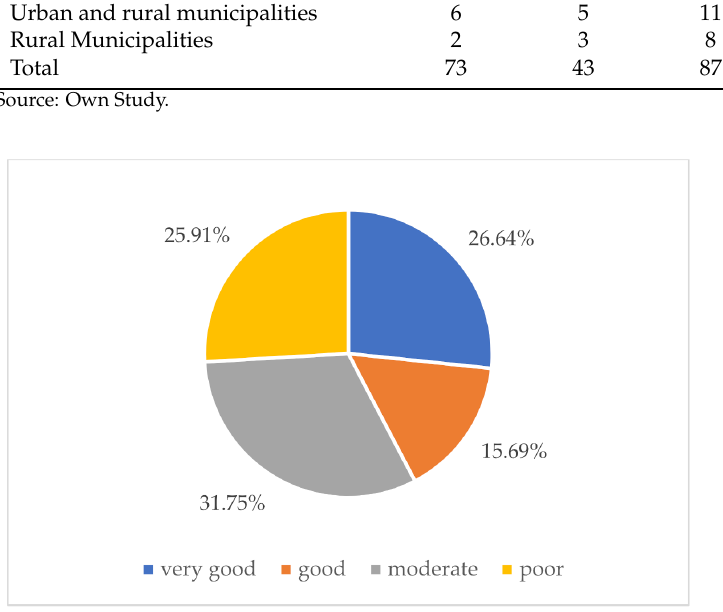
Figure 9. Knowledge of the EU climate and energy policy assumptions. Respondents could select only one answer. Source: own